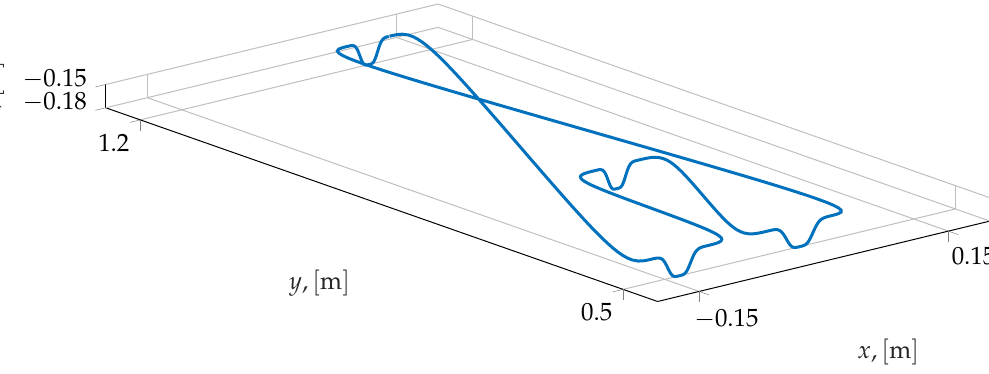
Figure 8. Support of the end-effector trajectory hypothesized as a reference